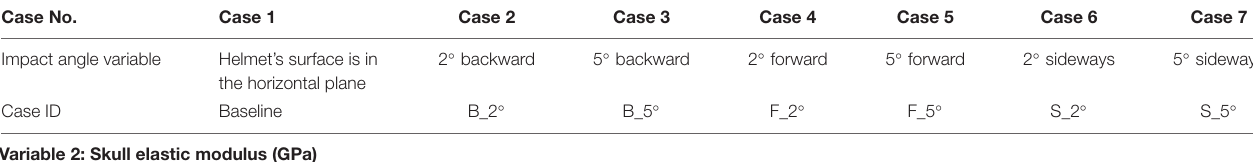
TABLE 3 | Simulation matrix on the effect of the initial conditions. Variable 1: Helmet angle off 2 or 5 degrees in sagittal and lateral plane Case No.